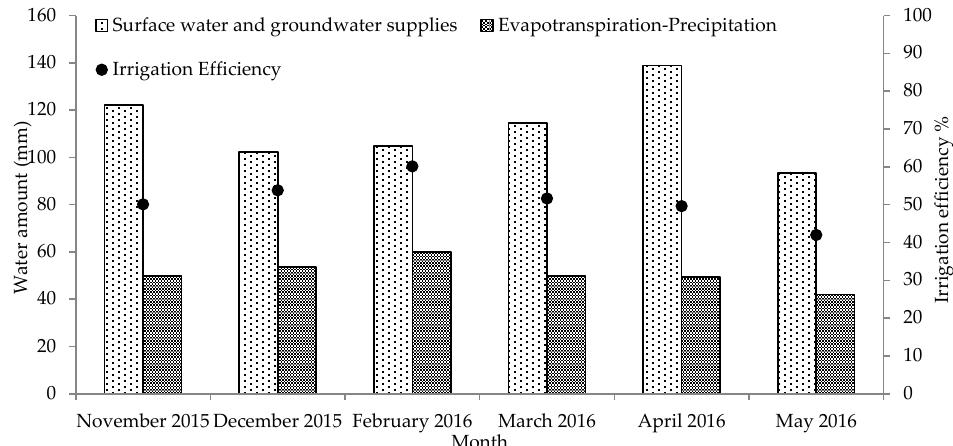
Figure 6. Average monthly water supplies (i.e., surface and groundwater), actual evapotranspiration minus precipitation ( ET C -P ), and the irrigation efficiency of the study area during the winter season (from November 2015 to May 2016).